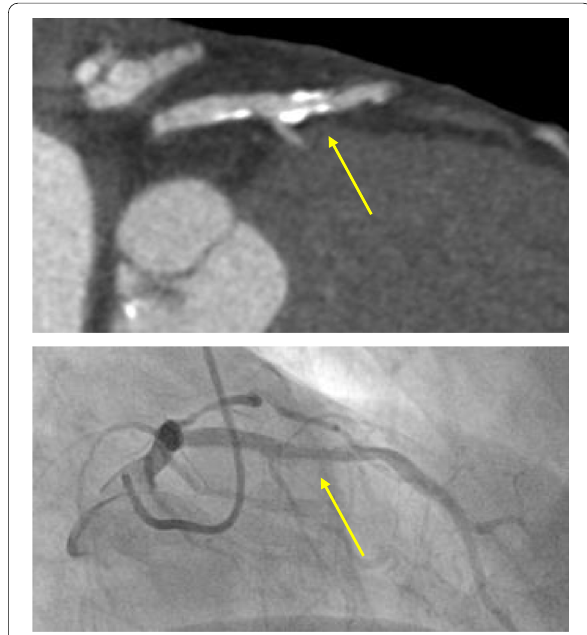
Fig. 1 In this example, the mid-left descending coronary artery lesion (yellow arrow) is calcified. Blooming artifact in the CT image results in overestimation of lumen stenosis in this area. Invasive coronary angiography (ICA) revealed a less severe stenosis than perceived on CT. Fractional fluid reserve for this lesion was 0.82. Image credit: Centro Cardiologico Monzino (used with permission)